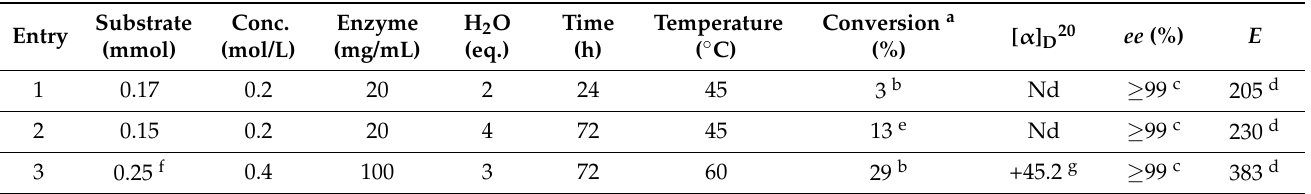
Table 1. Reaction conditions for the enzymatic resolution of the racemic mixture of rac-trans - 2 to obtain (u) - trans - 3